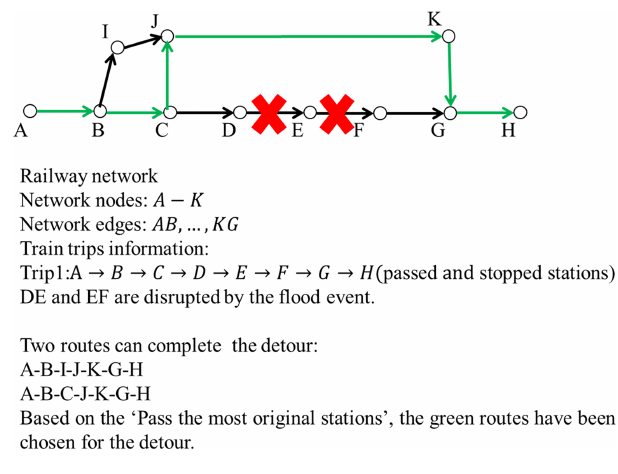
Figure A3. An example for